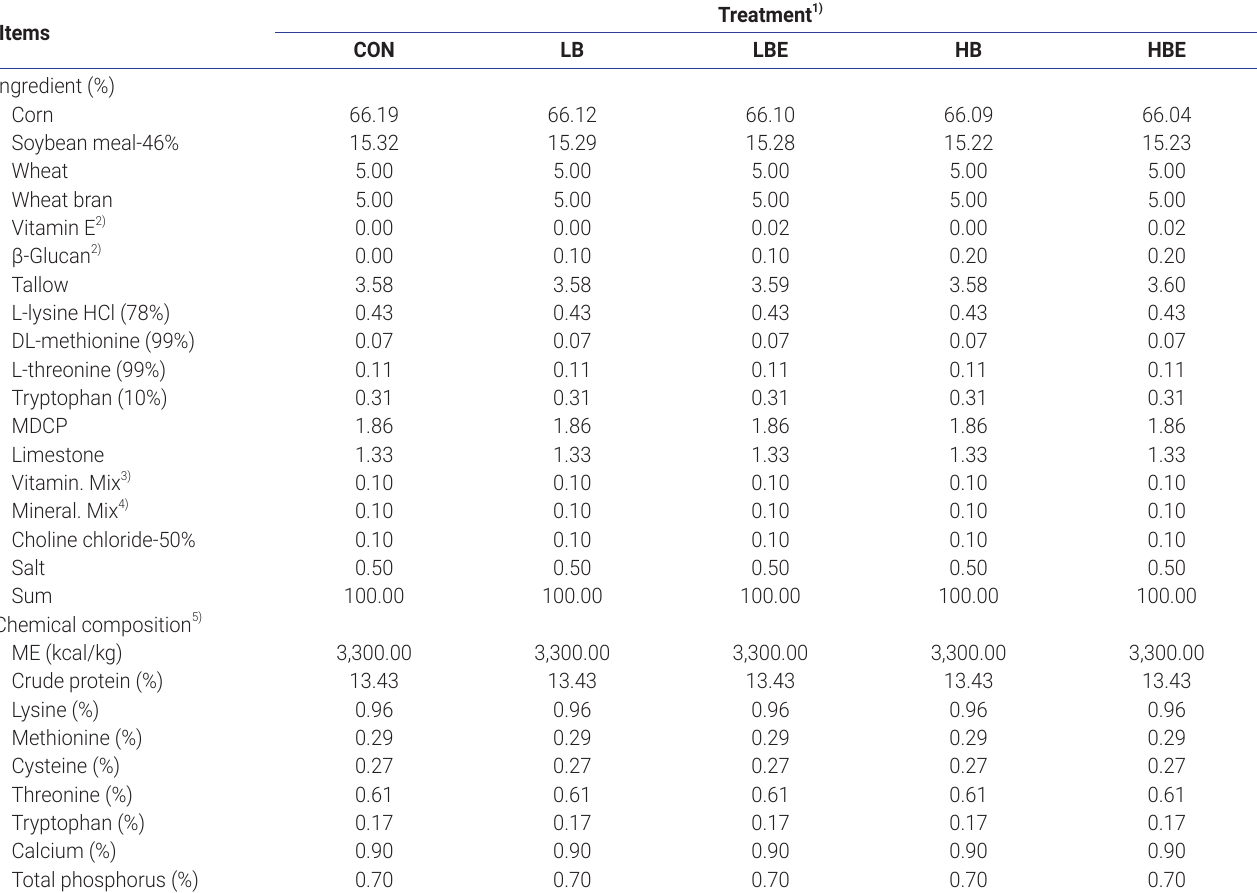
Table 1. Formula and chemical compositions of the experimental diets during the lactation phase